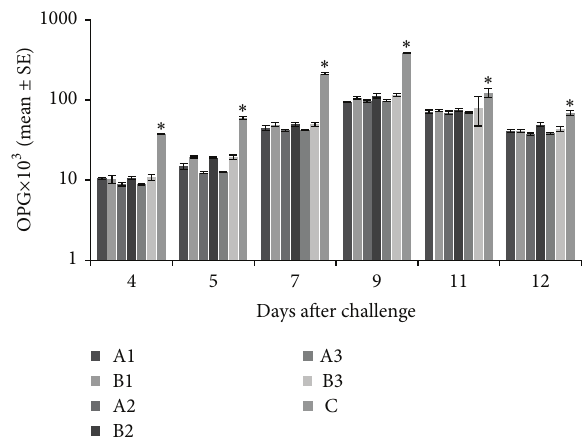
Figure 2: Oocysts per gram of droppings from day 4 to 12 after challenge in experimental and control chickens. A1 = Emblica officinalis derived tannins at 0.50 gm/Kg b. wt; B1 = commercial tannins at 0.50 gm/Kg b. wt; A2 = Emblica officinalis derived tannins at 0.75 gm/Kg b. wt; B2 = commercial tannins at 0.75 gm/Kg b. wt; A3 = Emblica officinalis derived tannins at 1.00 gm/Kg b. wt; B3 negative control ( ∗ significantly lower values).